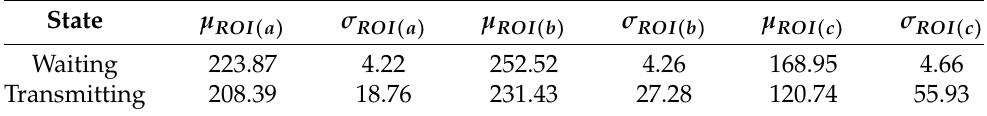
Table 1. Waking up examples from transmissions shown in Figure 6. The case (a) corresponds to gray-scale images of 640 × 480 taken in a room with the light turned on. For the case (b), the camera acquired color images of 1280 × 720 with default characteristics in a room where the light was turned off. In the last case (c), the camera’s settings were high contrast, low brightness, and low exposure time for 1280 × 720 color images taken in a room with the light turned